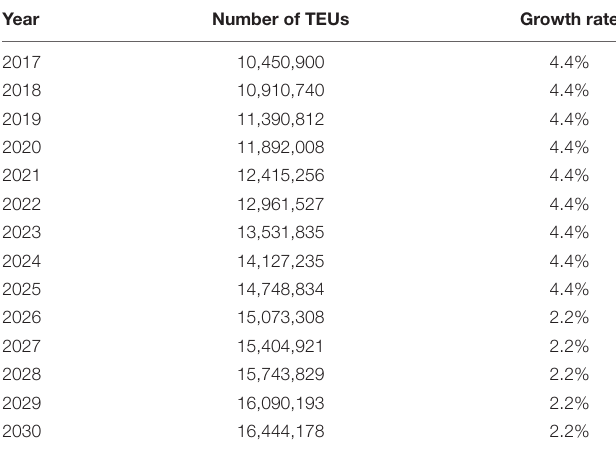
TABLE 2 | Forecast of handled TEU at Port of Antwerp until 2030 (Havenbedrijf Antwerpen NV,